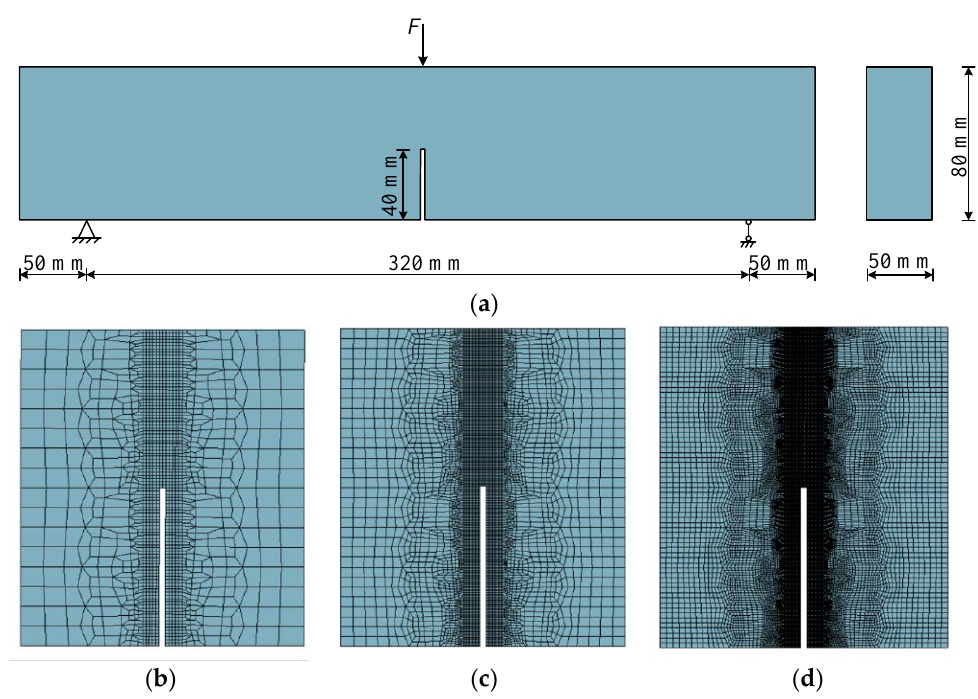
Figure 7. The three-point bending beam test: ( a ) dimensions and boundary conditions; ( b ) Coarse mesh; ( c ) Middle mesh; ( d ) Fine mesh.